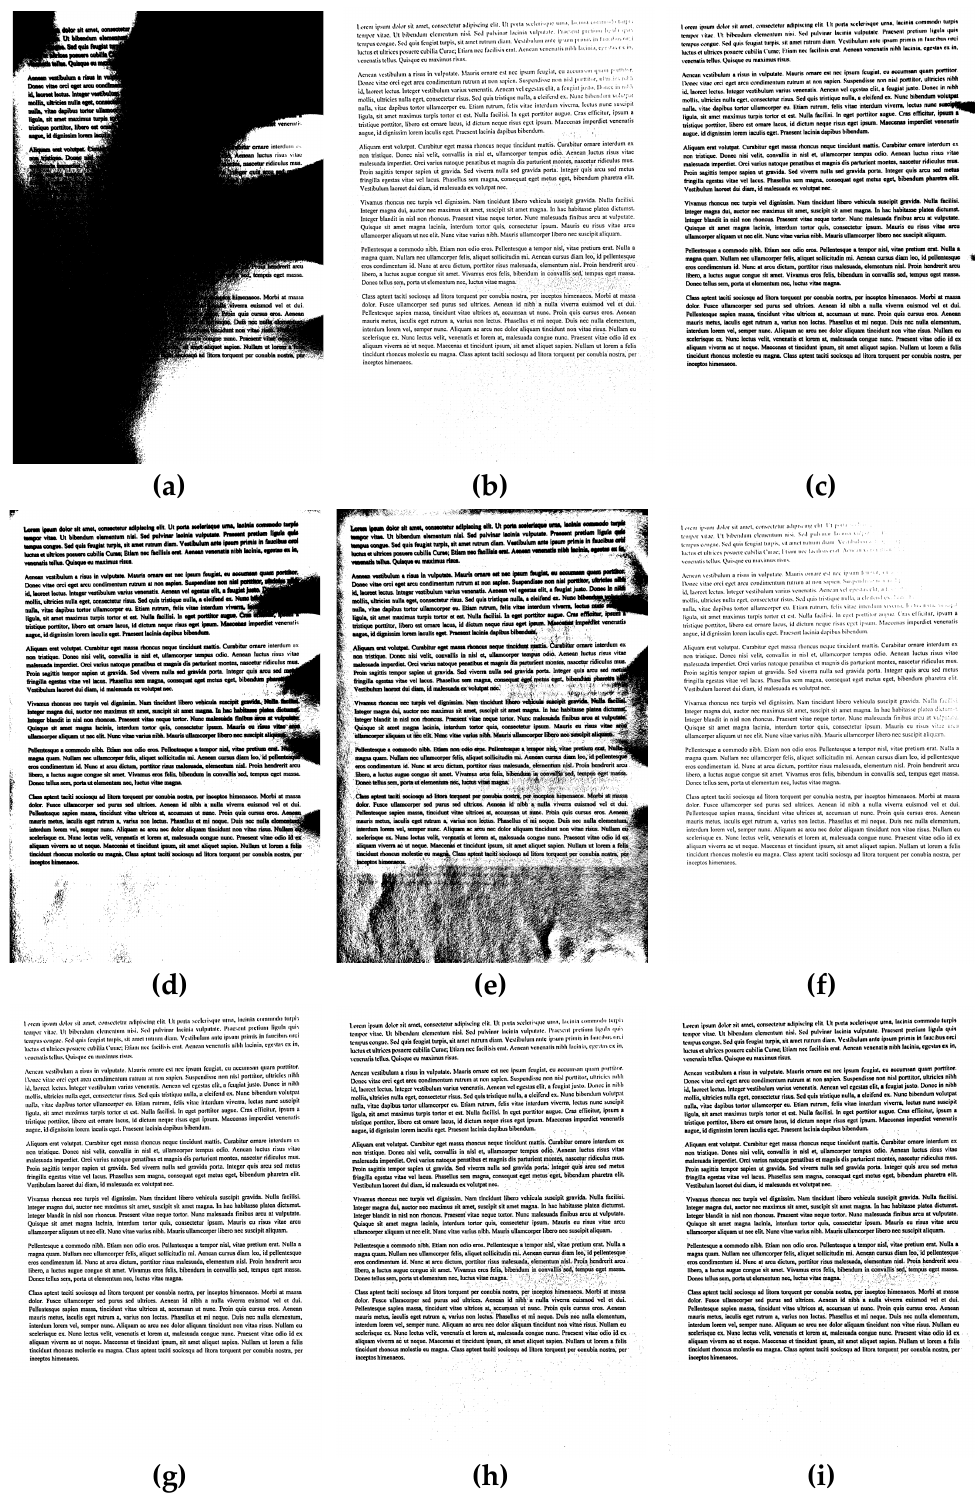
Figure 4. Binarization results obtained for a sample unevenly illuminated image from the dataset used in experiments shown in Figure 1c for various methods: ( a ) Otsu, ( b ) Niblack, ( c ) Sauvola, ( d ) Bradley (mean), ( e ) Bernsen, ( f ) Meanthresh, ( g ) NICK, ( h ) stack of regions (16 layers), and ( i ) proposed